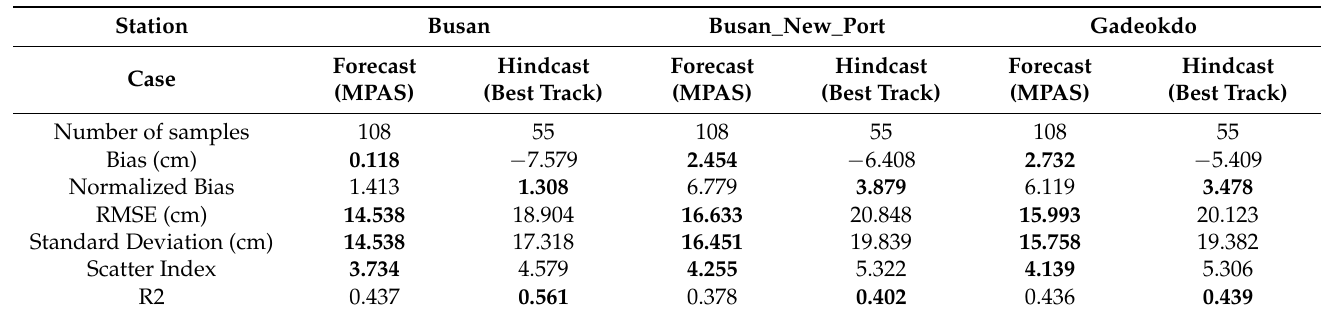
Table 8. Same as Table 7, except for typhoon